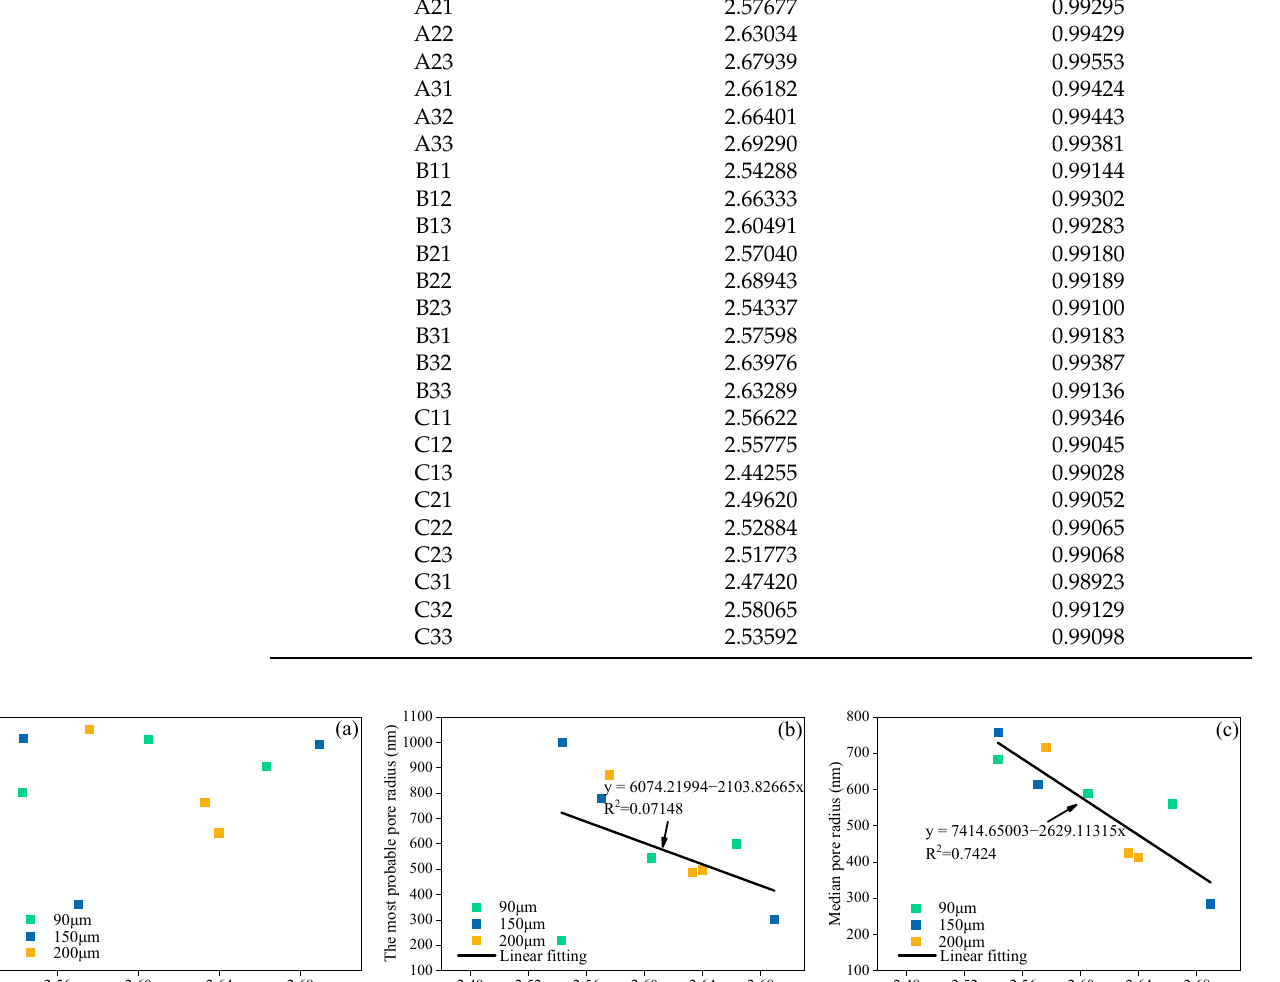
Figure 9. Relationship between D s and ( a ) porosity, ( b ) the most probable pore size, and ( c ) median pore radius for porous alumina samples with 50 vol.% pore-forming agents. The relationships between the D s and porosity, most probable pore size and median pore size of the samples with 70 vol.% pore-forming agents are shown in Figure 10. The